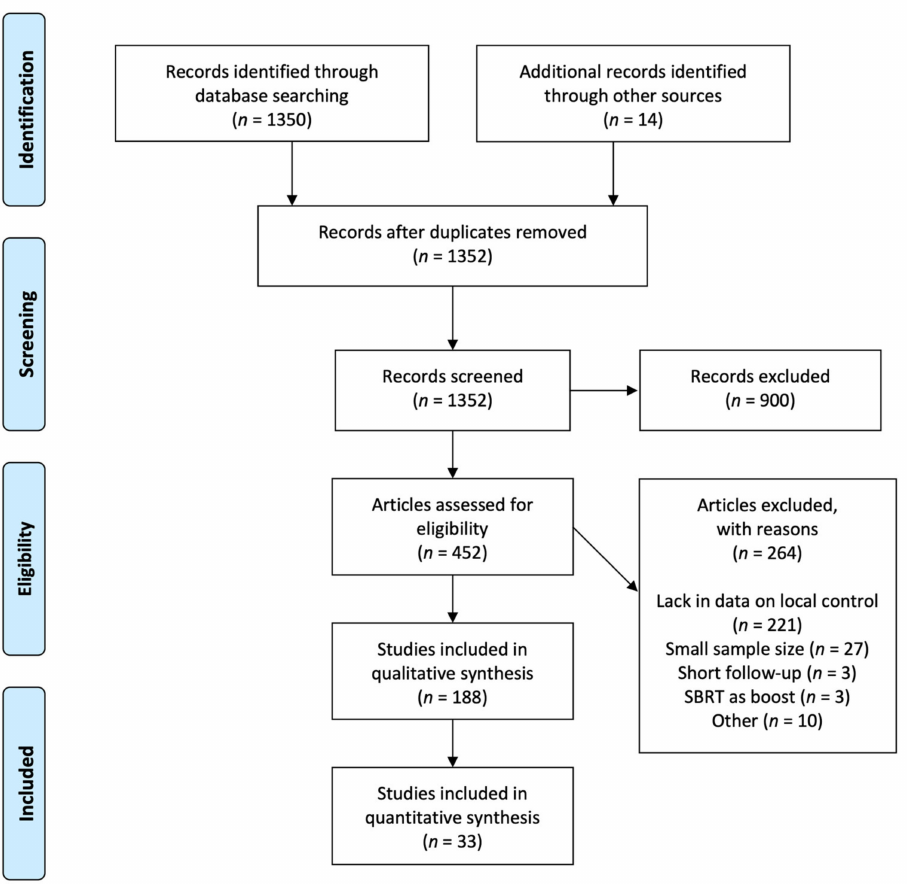
Figure 1. Flow chart for study